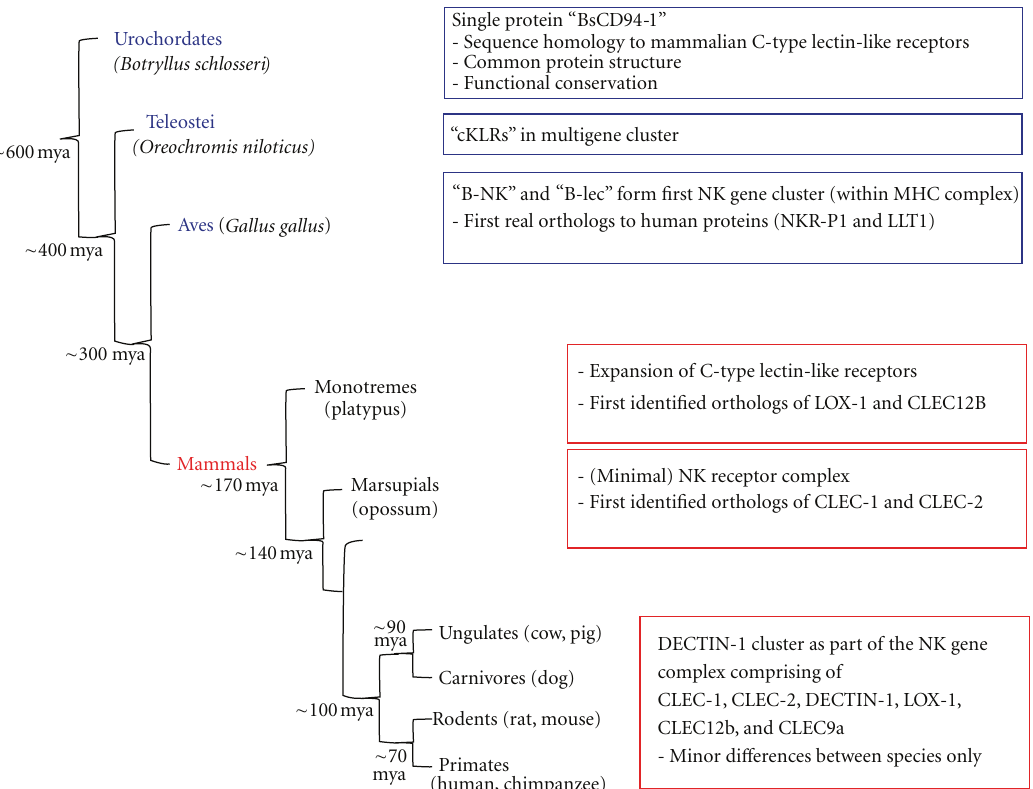
Figure 2: Evolutionary emergence of the C-type lectin-like receptors of the DECTIN-1 cluster. Schematic presentation of the evolutionary emergence of the members of the DECTIN-1 cluster. First transmembrane C-type lectin-like receptors appear in evolutionary old species like urochordates. However, orthologs of receptors of the DECTIN-1 cluster are restricted to mammals. Numbers indicate approximate divergence times in million years. cKLR: cichlid killer cell C-type lectin-like receptors, NKR-P1: natural killer receptor-P1, LLT1: lectin-like transcript-1, MHC: major histocompatibility, mya: million years